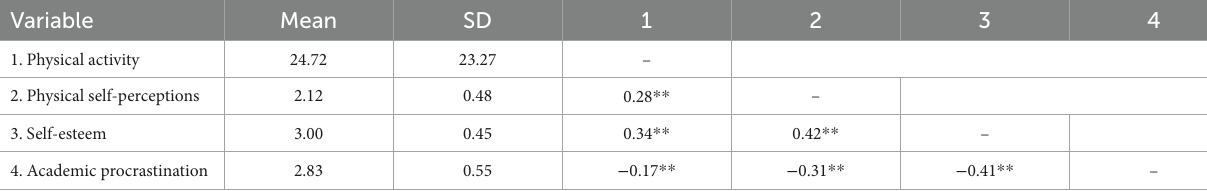
TABLE 1 Descriptive statistics and correlations among variables ( N = 916).